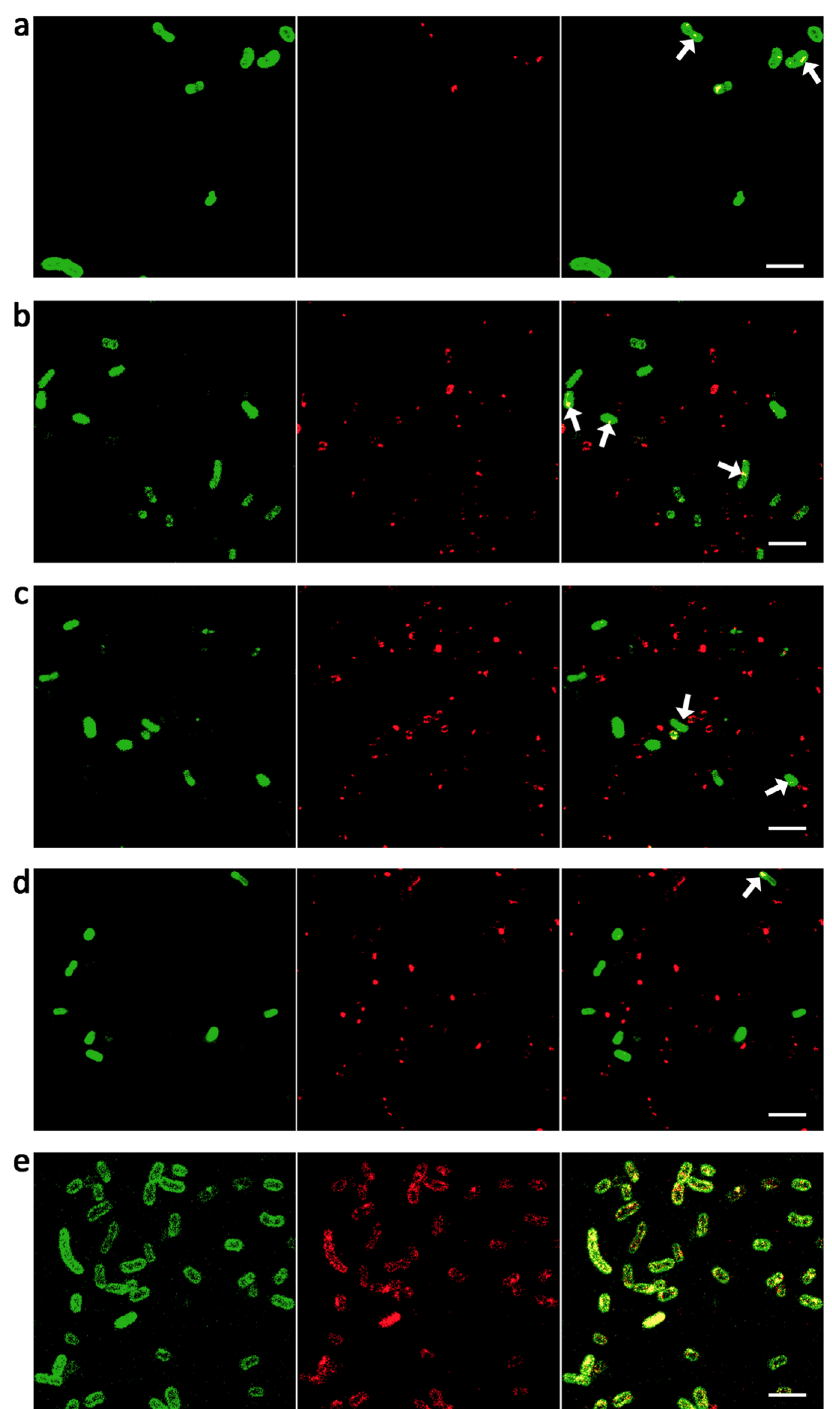
Fig. 3 Confocal images of viable A. baumannii ATCC 19606 labeled with Fix 488 (in green) in the outer membranes. Cubosomes were labeled with Octadecyl Rhodamine B Chloride (in red), such that the interactions between bacteria and cubosomes would be visible through the colocalization of their individual fl uorescence emission in the micrographs. The white arrows indicate the slight interaction of cubosomes or PMB-loaded cubosomes with bacteria. All the images are representative of experiments performed in triplicate ( n = 3). A. baumannii ATCC 19606 treated with ( a ) 32 μ g/mL cubosomes alone; b 1 wt% PMB-loaded cubosomes; c 8 wt% PMB-loaded cubosomes; d 20 wt% PMB-loaded cubosomes and e polytherapy treatment with 32 μ g/mL unloaded cubosomes and 0.5 μ g/mL of PMB. Left: bacteria in green; middle: cubosomes in red; right: overlay image. Scale bar: 4 μ OM of Gram-negative bacteria — PMB treatment followed by the membrane structure. Thus, PMB was prevented from reaching cubosome treatment . Similarly, as to the prior study, the NR data the OM due to blockage by the cubosomes which overlaid the OM con fi rmed the presence of the membrane bilayer with a high- surface. The lack of membrane damage associated with PMB- volume fraction of lipid of 98.1 ± 3.5% across the SiO 2 surface loaded cubosomes agrees with the in vitro results (Fig. 2).